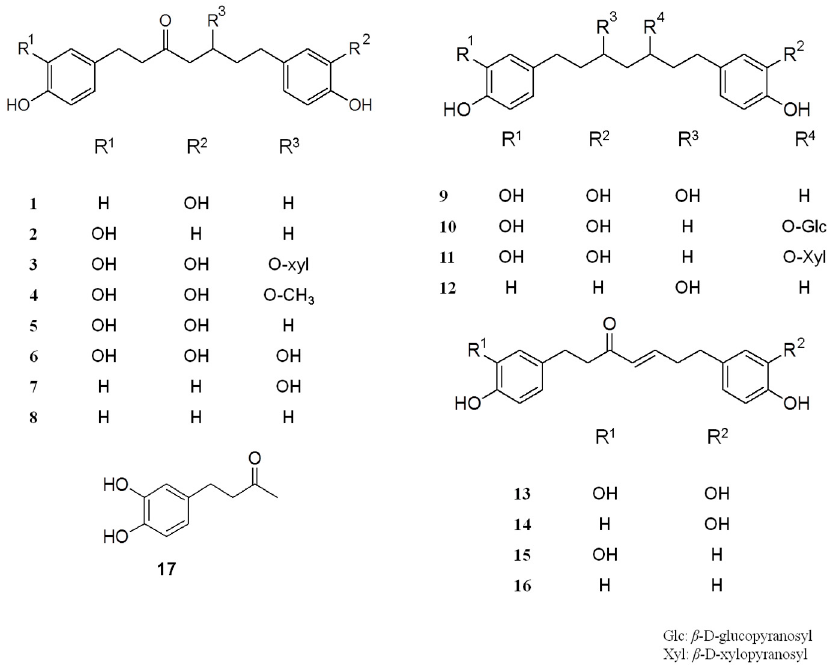
Figure 1. Structures of compounds 1 – 17 .